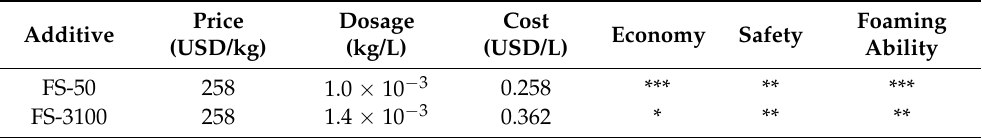
Table 6. Evaluation of FS-50 and FS-3100 as additives for SRP foaming agent.